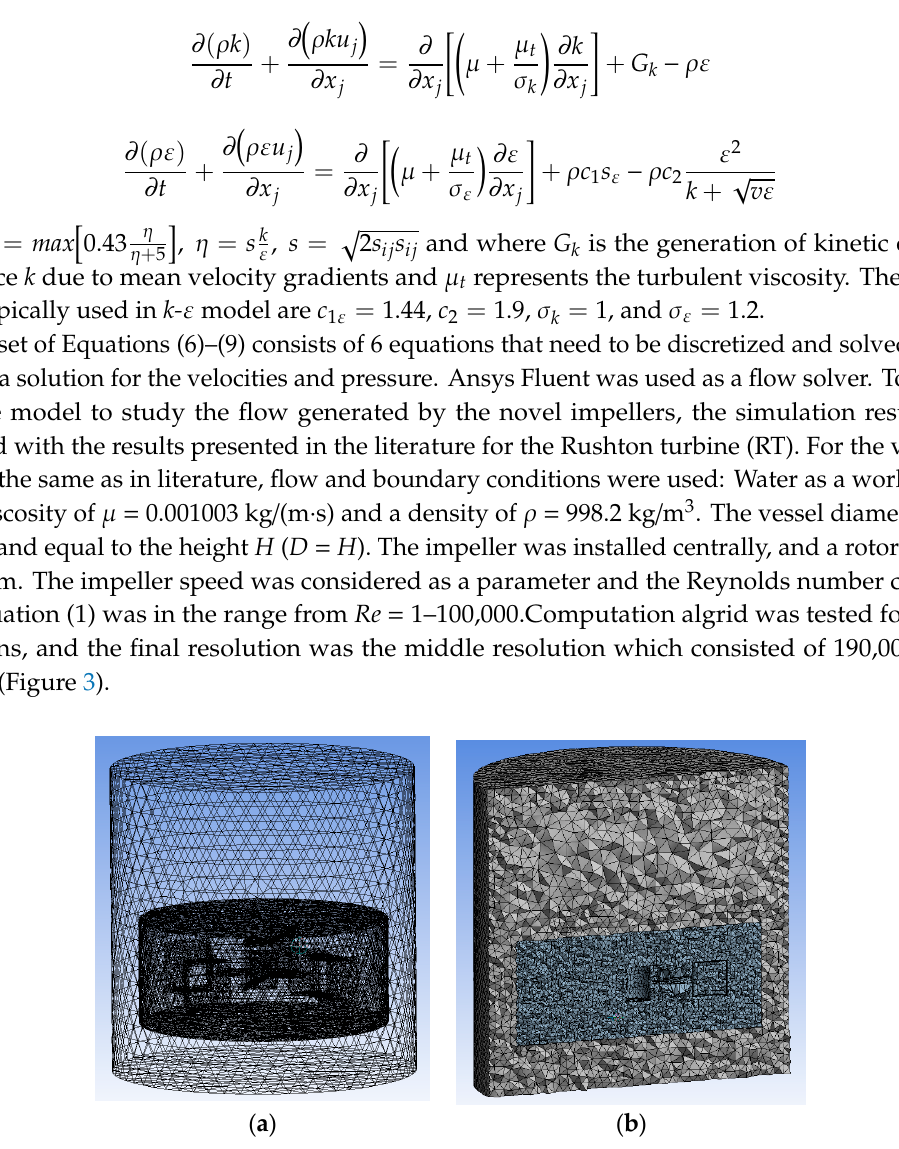
Figure 3. Mesh of the computational domain for Computational Fluid Dynamics (CFD) simulation global view ( a ) and inside the domain ( b ).